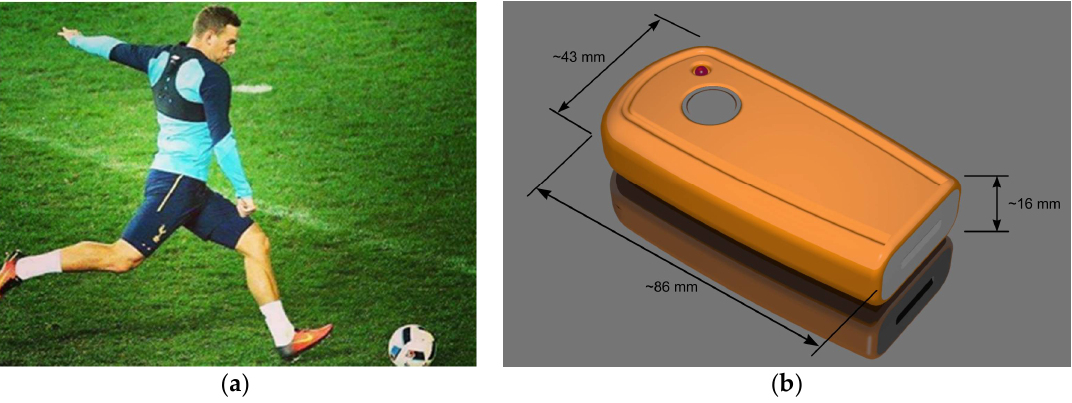
Figure 1. ( a ) Example of an upper-back mounted EPTS device worn during match-play; ( b ) illustration of mock-EPTS device (dimensions representative of current EPTS